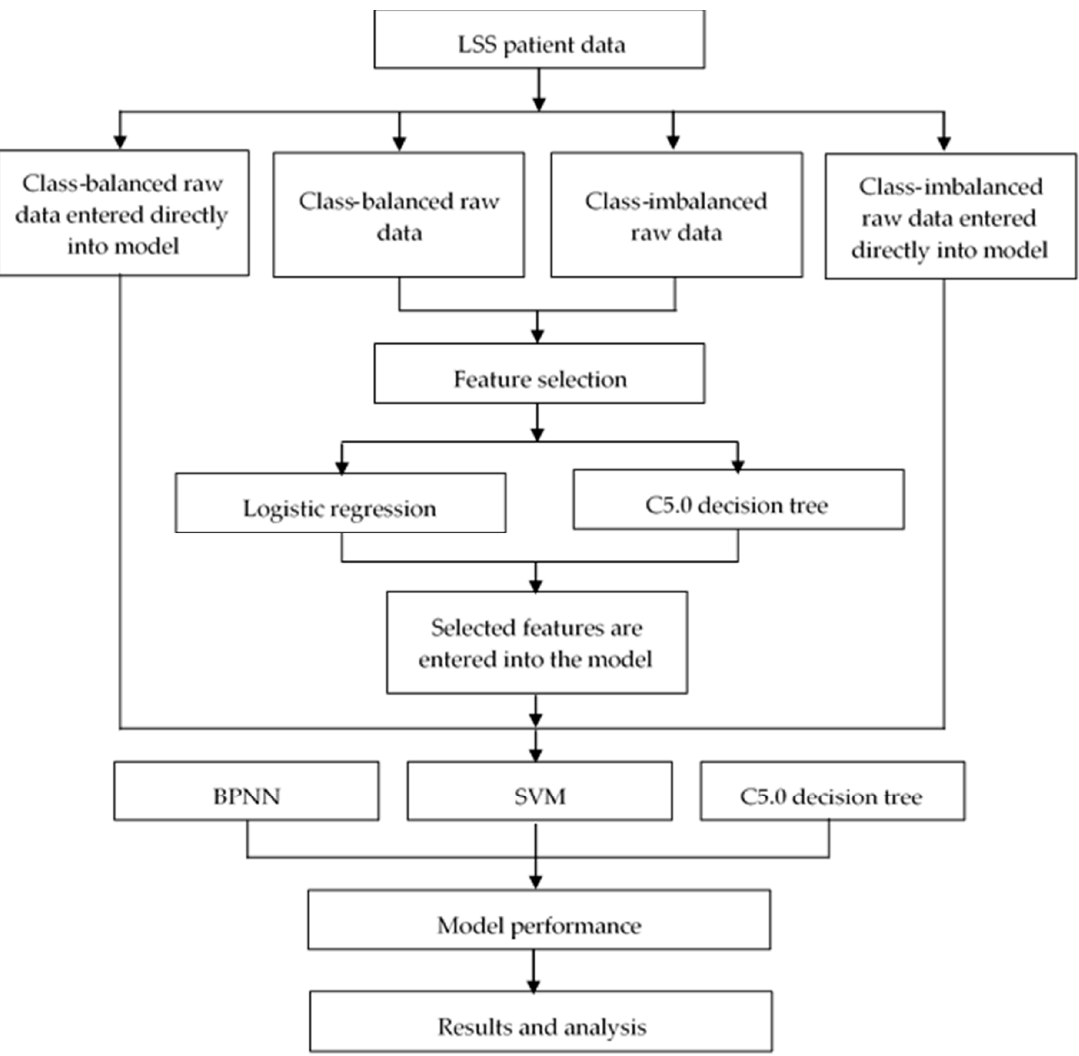
Figure 1. Research Flowchart for Building Prediction Models.